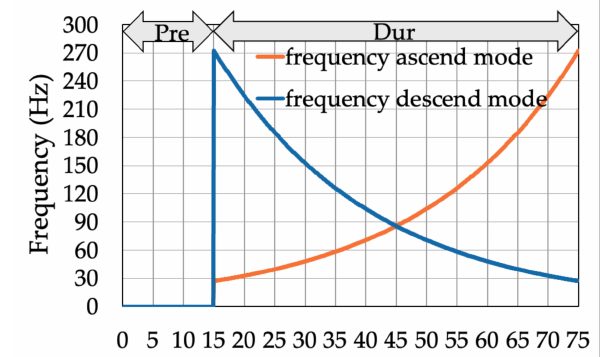
Figure 3. Sweep frequency of local vibratory stimulation.